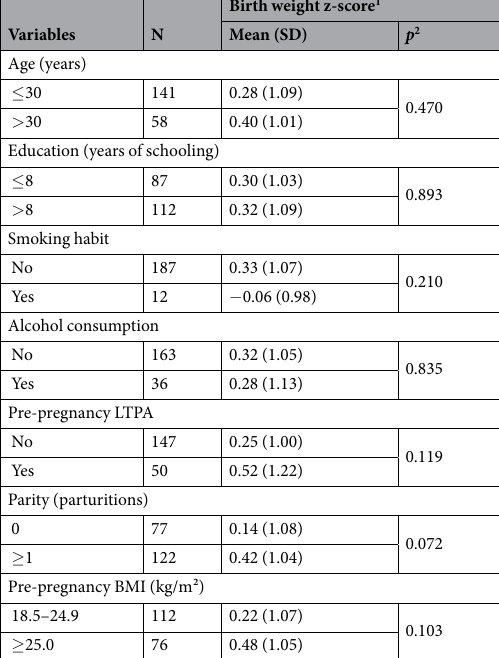
Table 3. Mean birth weight z-score according to maternal characteristics in a sample of pregnant women and their newborns followed at a public health centre in Rio de Janeiro city, Brazil, 2009–2012. 1 Birth weight z-score was classified according to the international foetal and newborn growth consortium for the 21 st Century (Intergrowth-21 st ) curves. 2 p-value refers to unpaired Student’s t test. Abbreviations: BMI = body mass index; LGA = large for gestational age; LTPA = leisure time physical activity; SD = standard